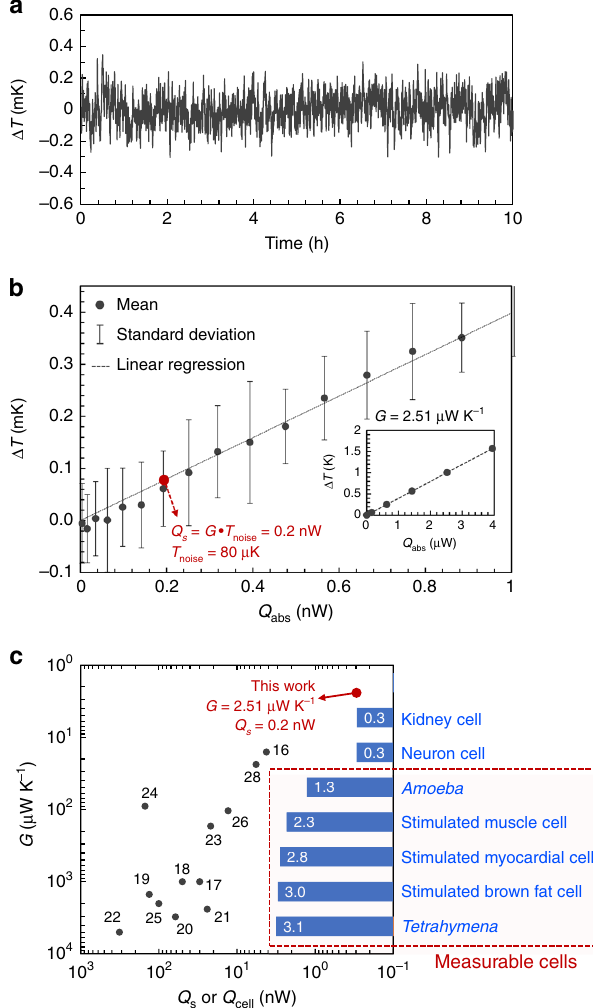
Fig. 2 Baseline temperature stability and sensitivity of